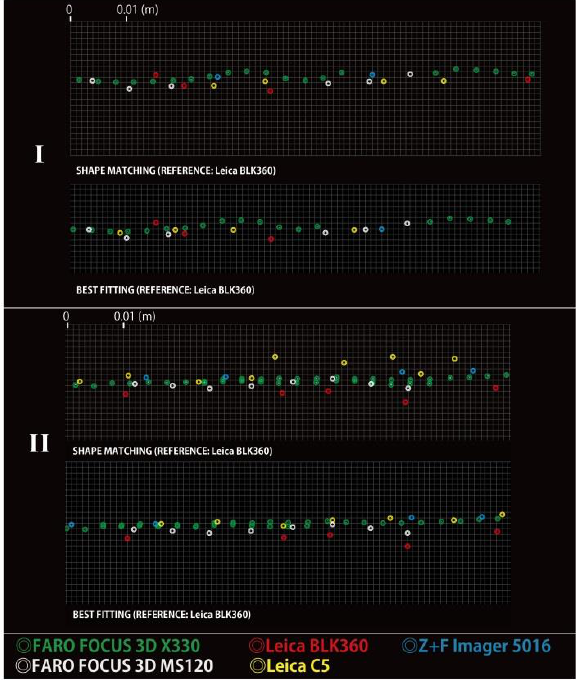
Figure 15: Alignments of Point Clouds (Refference:Z+F Imager